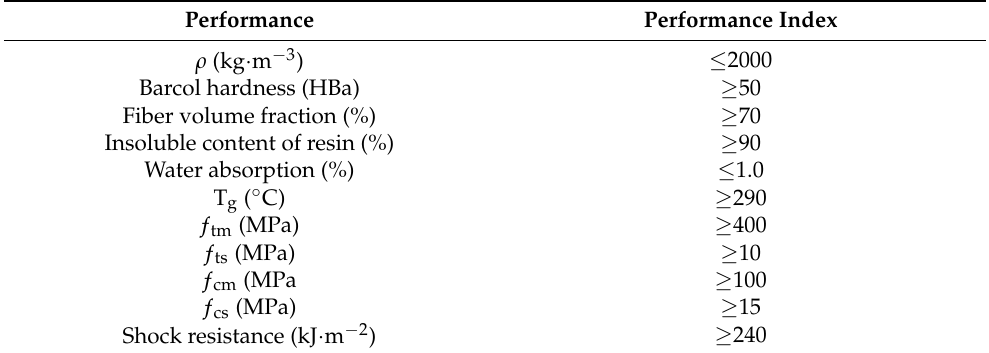
Table 1. Physical and mechanical properties of the nanometer montmorillonite composite fiber material.